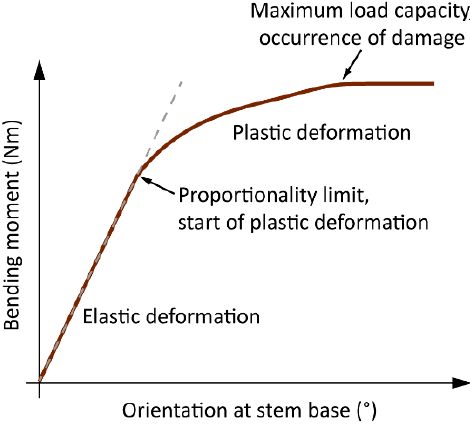
Figure 10. Idealized dependence of tree response at stem base to wind loading. The relationship is based on examples provided in previous studies [24,27,28].